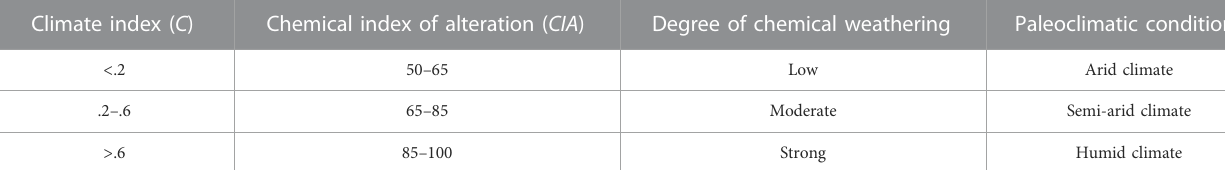
TABLE 1 Paleoclimate discrimination criteria based on the climate index (C) and chemical index of alteration (CIA) degree.